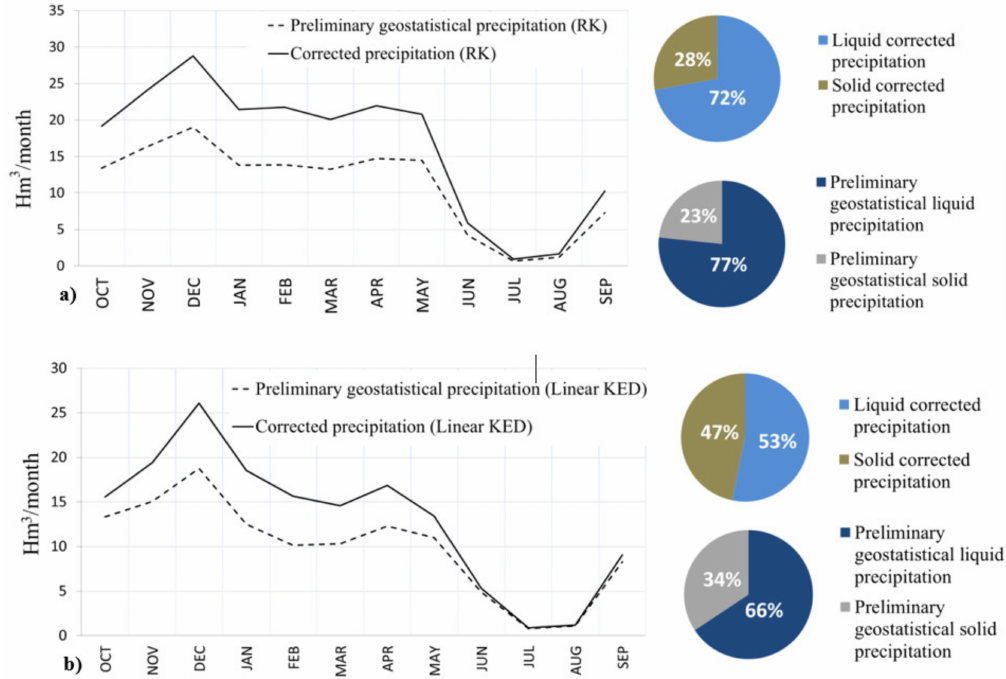
Figure 8. Estimated monthly mean precipitation and its annual distribution between solid and liquid phases (preliminary geostatistical fields vs. corrected fields); ( a ) RK model; ( b ) linear KED